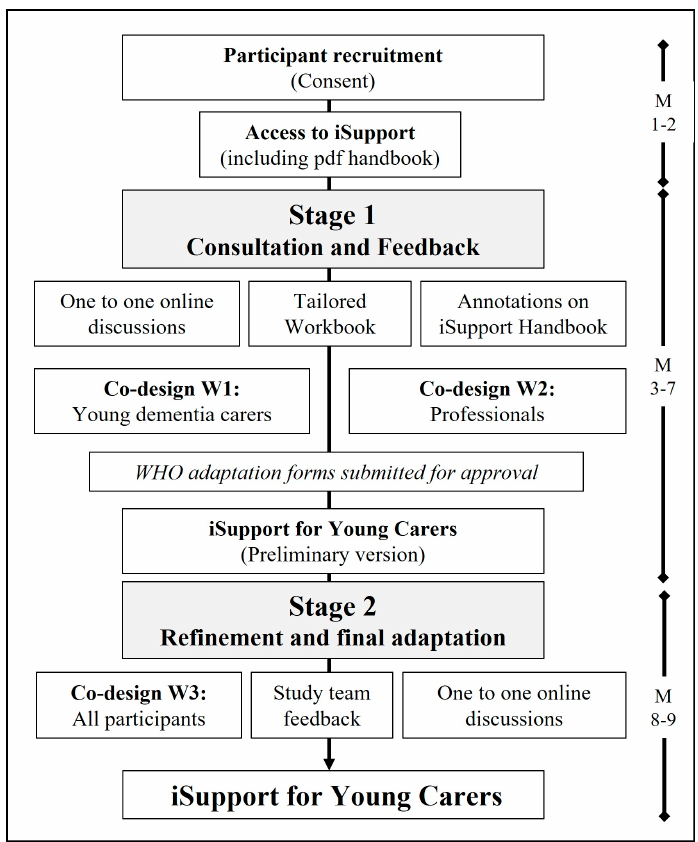
Figure 2. Adaptation process including timeline (M: month).